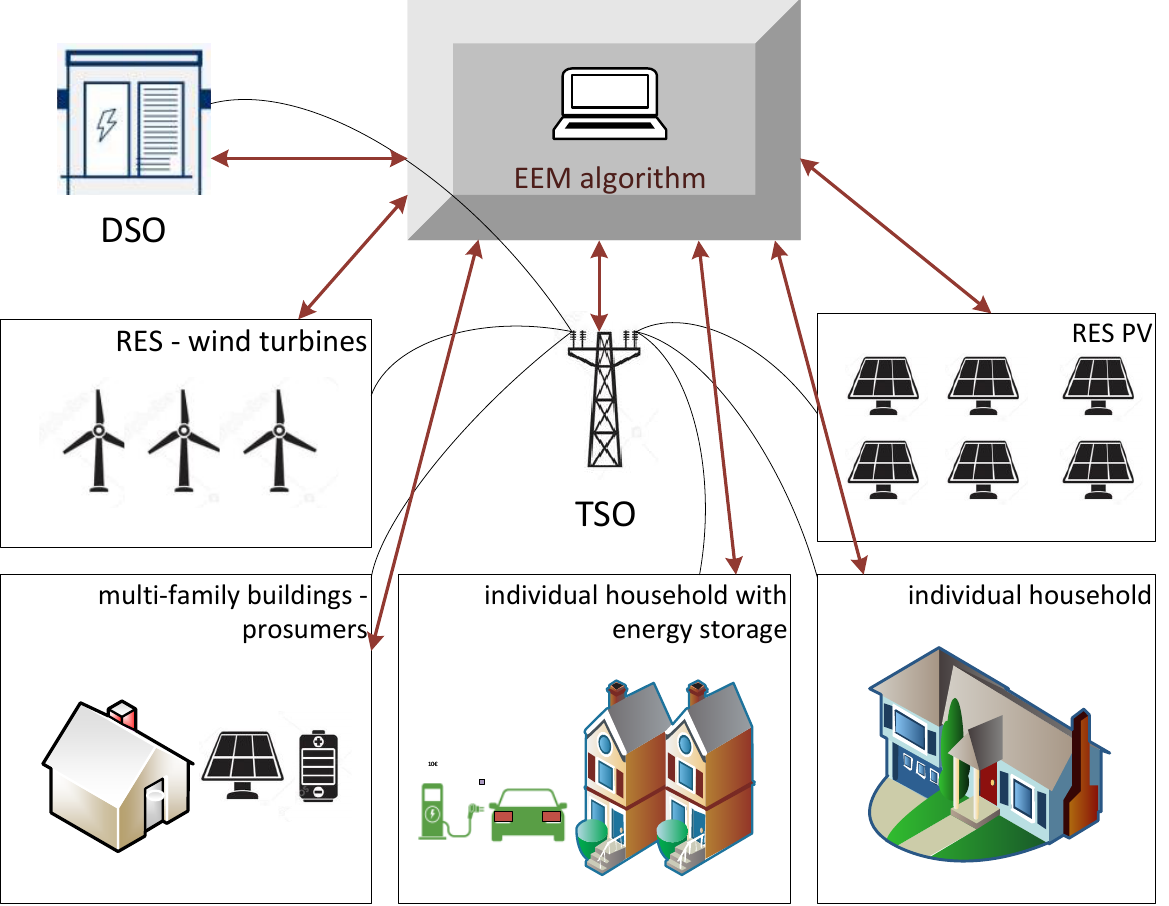
Figure 1. Structure of the power system with the EEM